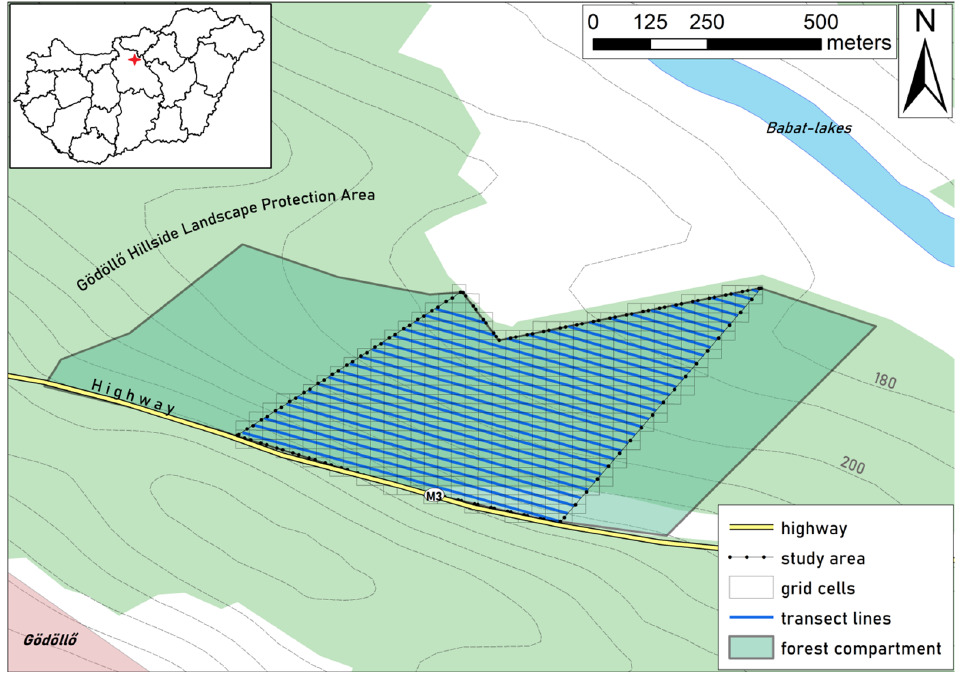
Figure 1. Location of the study area and design of the grid of 20 × 20 m cells in 21.5 ha in the Babat Valley, Hungary. The red star on the overview map indicates the location of the study area in Hungary.